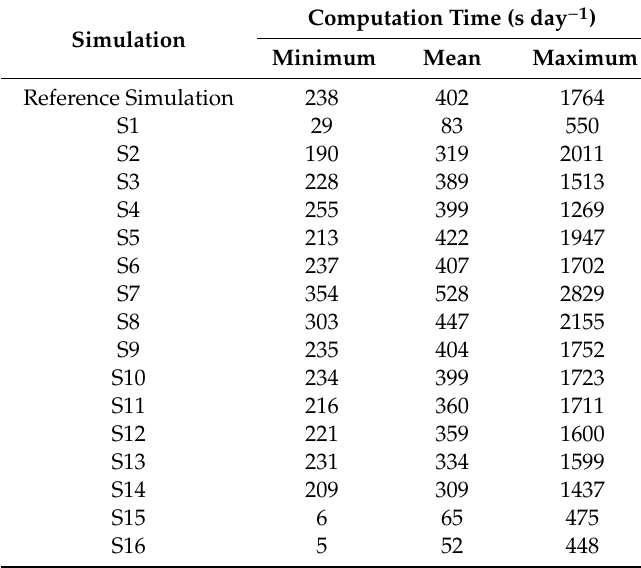
methods; 14, 15, and 16—porous media and vegetation processes (see Section 2.4 for details)